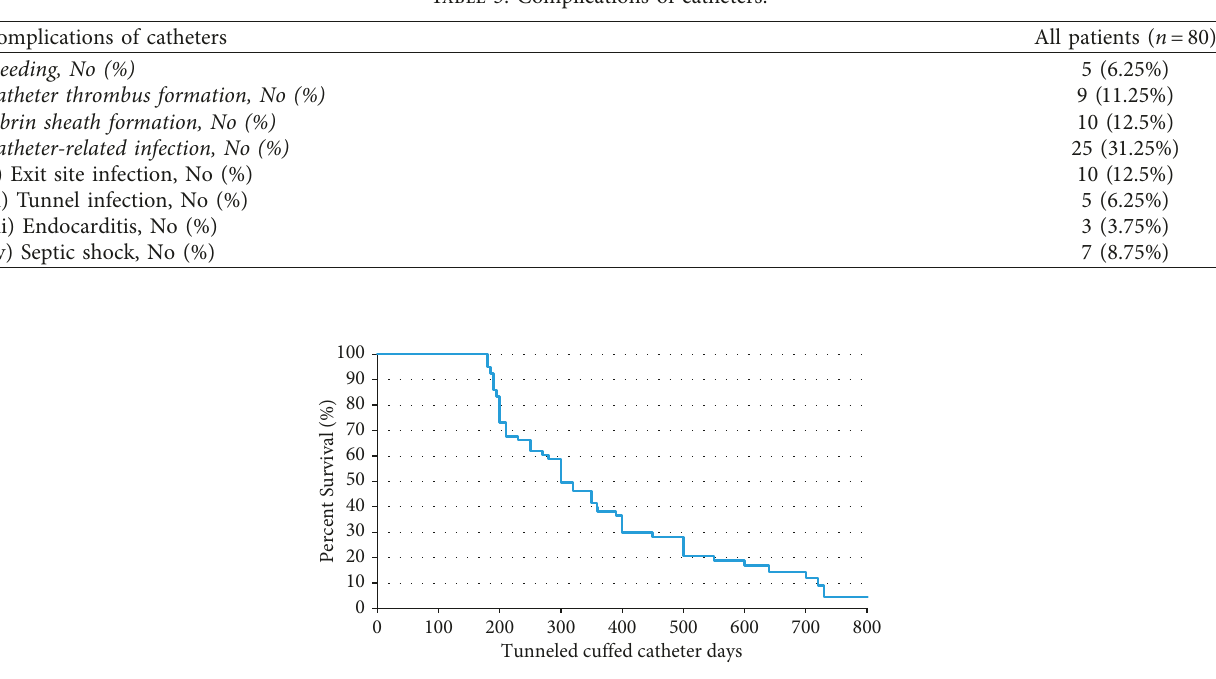
Figure 2: Kaplan–Meier survival curve showing survival rate of iliac vein tunneled cuffed catheter (survival probability was 75%. Mean